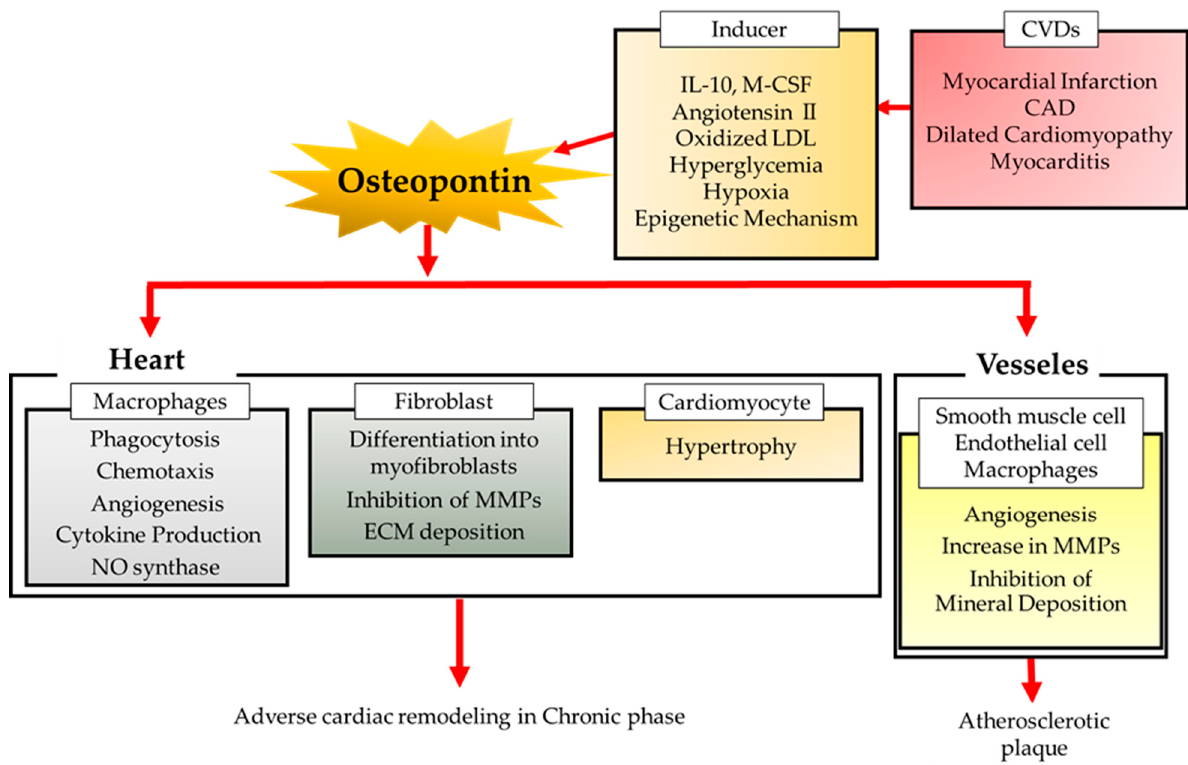
Figure 1. OPN in cardiac remodeling. OPN is involved in a number of CVDs, including ischemic heart diseases, hyperten- sion, heart failure, dilated cardiomyopathy, atherosclerosis, and several cardiomyopathies and the major source and role of OPN is dependent on pathological states. A number of stimuli are shown to promote OPN expression, including cytokines, ROS, Ang II (angiotensin II), high glucose, hypoxia, and epigenetic mechanisms. Different cell types and pathological states differ in their regulatory mechanisms of OPN in the heart and vessels.